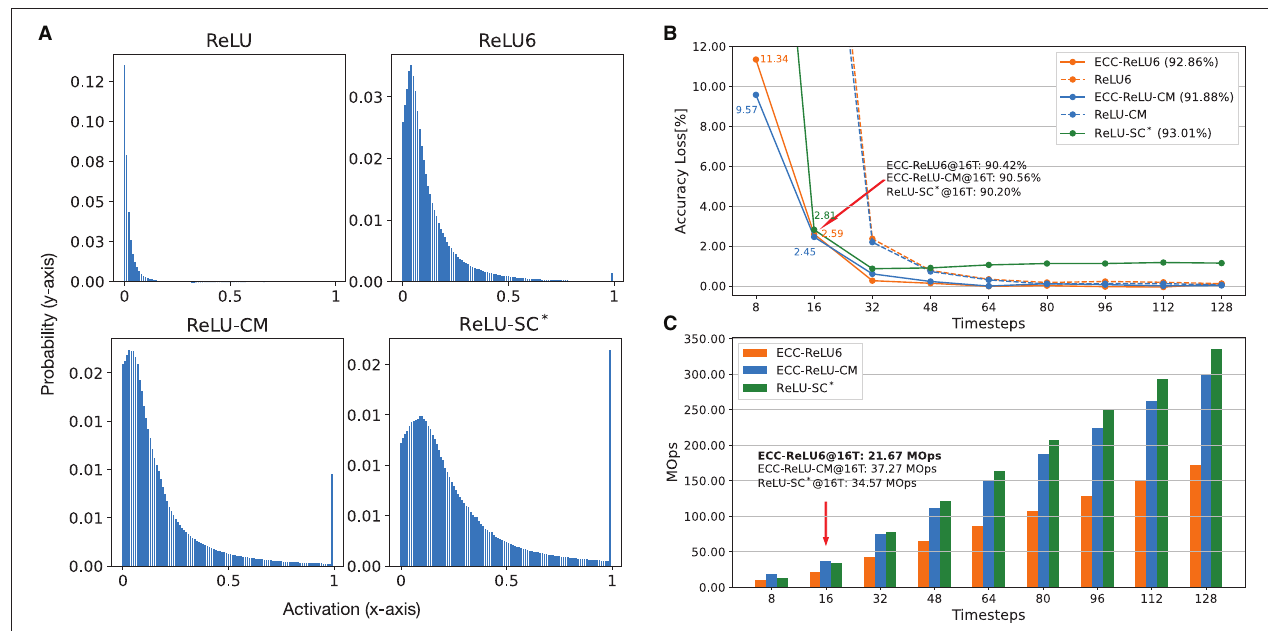
FIGURE 6 | Comparison of SNNs using different clipping methods, ReLU6 (Jacob et al., 2018; Lin et al., 2019), ReLU-CM (Yu et al., 2020), ReLU-SC* (Deng and Gu, 2021), for CIFAR-10 on VGG-16. (A) Normalized activation distribution of the first layer. (B) Accuracy with respect to timesteps. (C) Energy consumption (MOps) with respect to timesteps. *We use ReLU-SC to train an SNN with a fixed timestep (16T), as it does not need extra training.